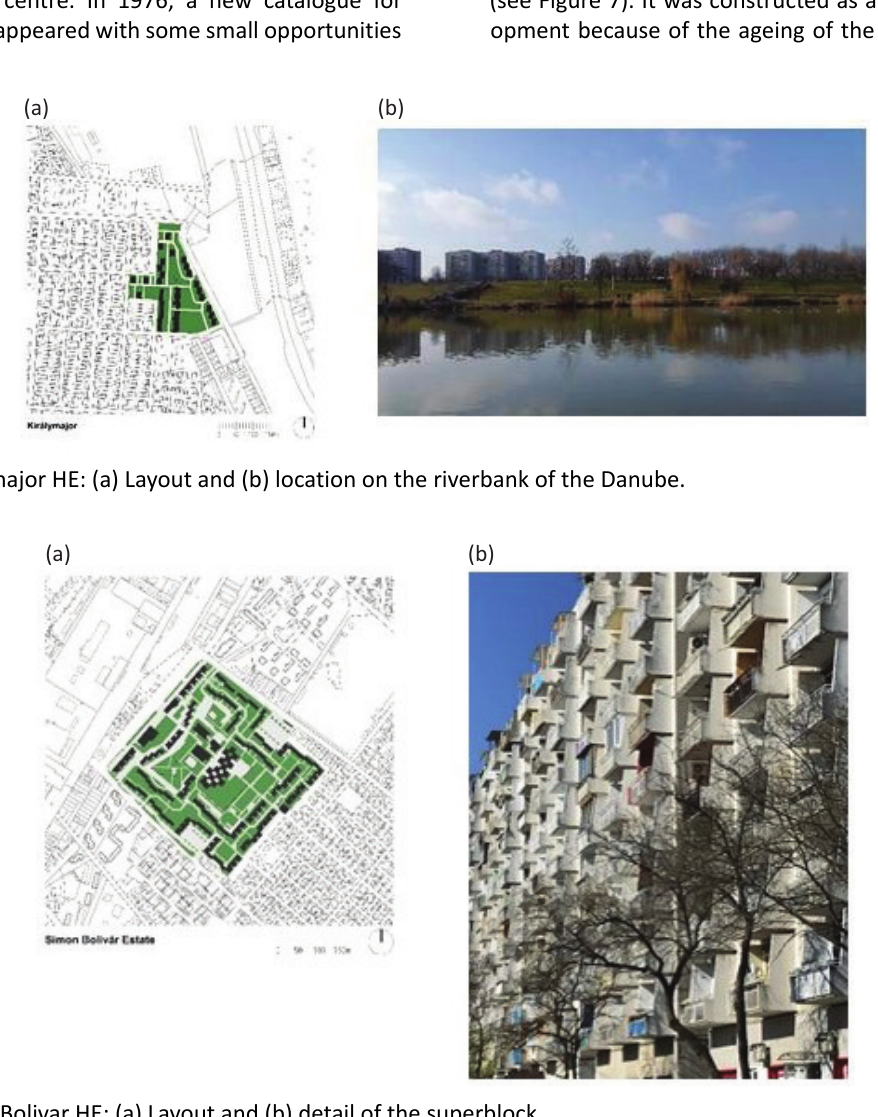
Figure 6. Simon Bolivar HE: (a) Layout and (b) detail of the